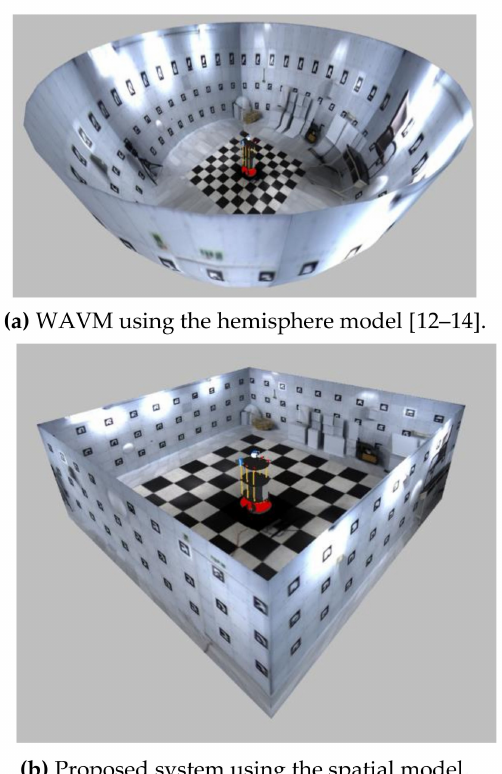
Figure 1. Demonstration of the wrap-around view monitor